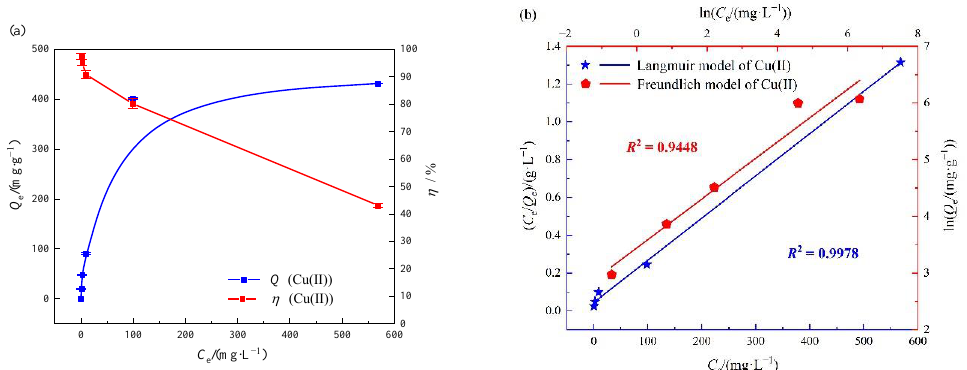
Figure 4. ( a ) Adsorption isotherms and ( b ) Linear fitting plots of Langmuir and Freundlich models